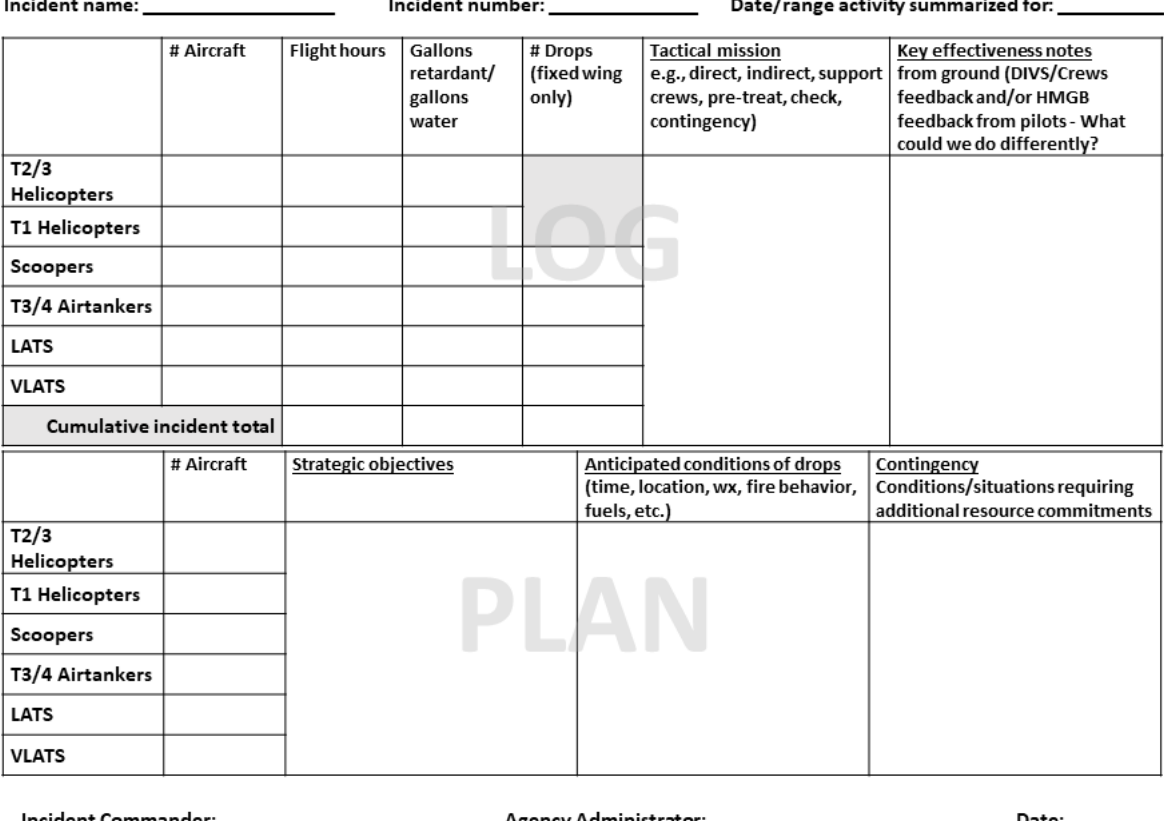
Figure 9. Prototype Aviation Daily Strategy Check-in tool.